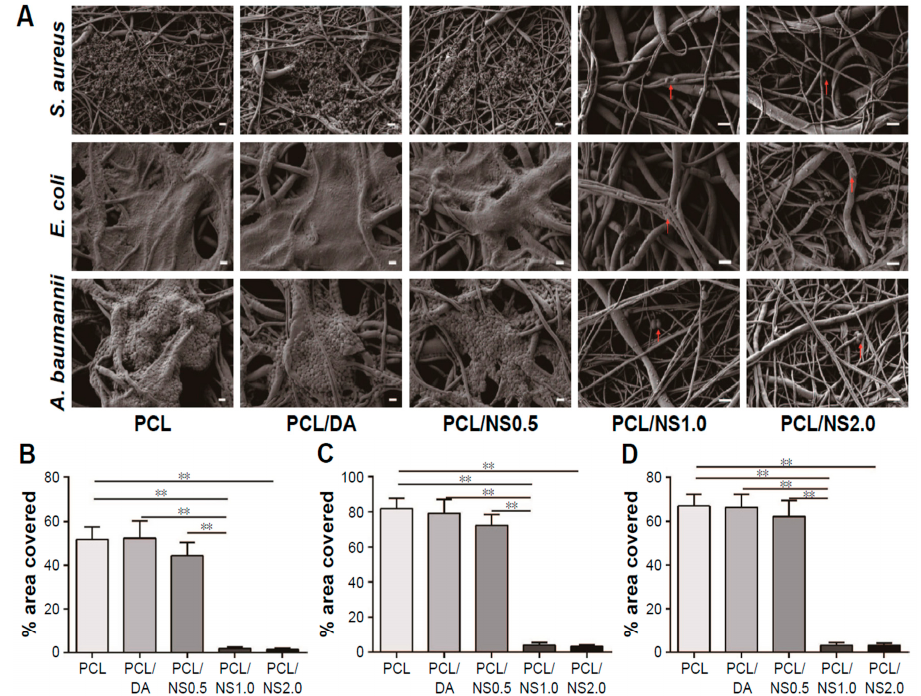
Figure 25. ( A ) SEM images of biofilms formed on PCL, PCL/DA, PCL/NS0.5, PCL/NS1.0 and PCL/NS2.0 mat surfaces; Scale bars: 1 µm. Red arrows indicate adherent bacteria. Measured areas covered by the biofilms of ( B ) S. aureus , ( C ) E. coli and ( D ) A. baumannii . ** p < 0.01 . Reproduced with permission